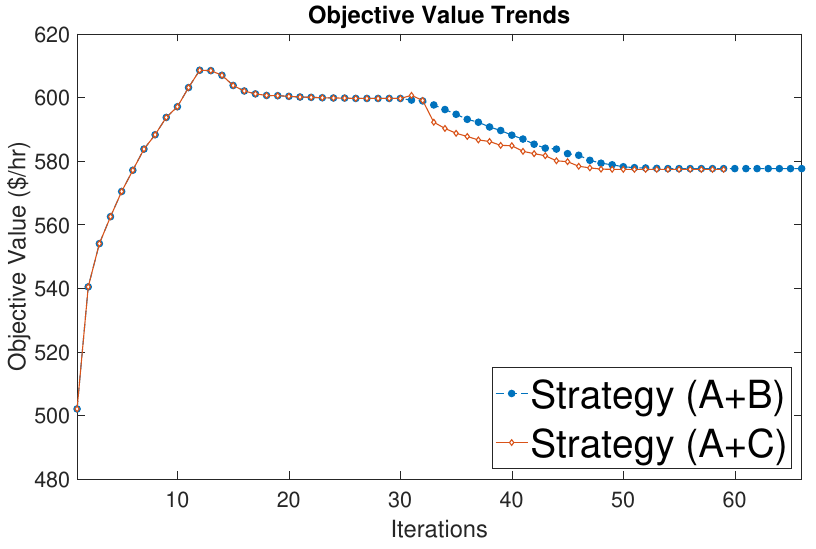
Figure 6. The 30 bus objective value. Regionalization strategies generated by AR and denote TBS-AR as strategy A, MBS-AR as B and WMBS-AR as C. Strategy A+B (blue line) is the combination of regionalization strategies A and B, Strategy A+C (red line) is the combination of regionalization strategies A and